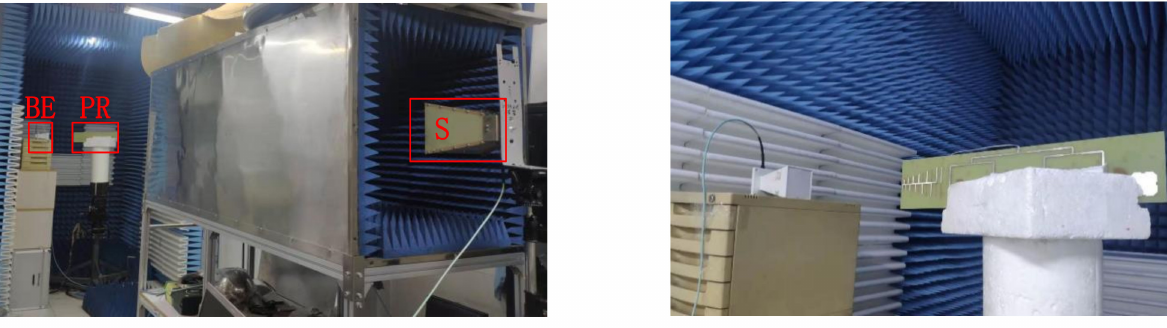
Figure 23. Measurement system